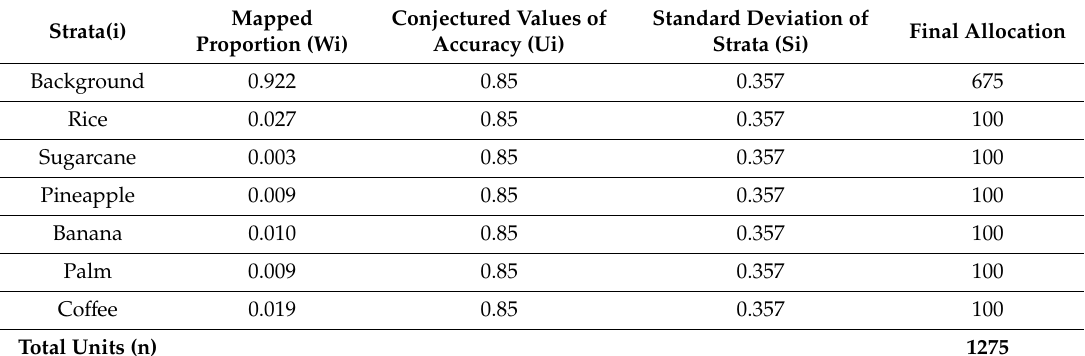
Table A2. For a stratified random assessment of the agricultural land cover map, the number of testing points per stratum was determined following the guidelines of Olofsson et al. (2014). The allocation of points in each stratum was determined through iterative conjecture [58].